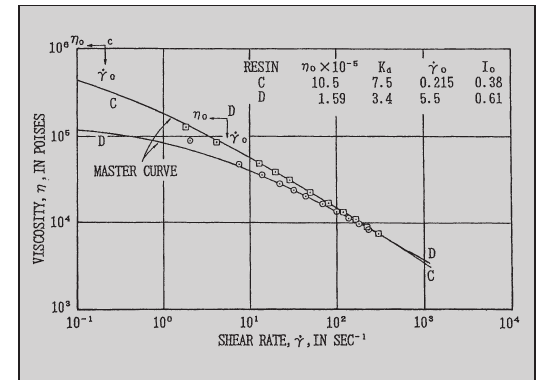
Figure 2 (left): Steady-state flow curves of resins A and B at 190°C. Figure 3 (right): Examples of capillary flow data and two-parameter curve fitting-imperfect